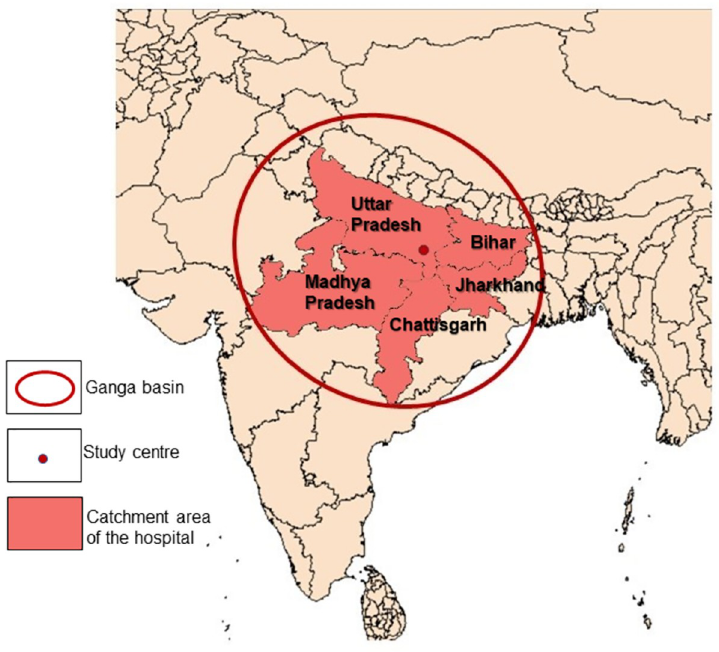
Fig 1. Catchment area of the hospital indicating the study centre and the Gangetic belt. Made with Natural Earth (link: https://www.naturalearthdata.com/downloads/10m-cultural-vectors/).